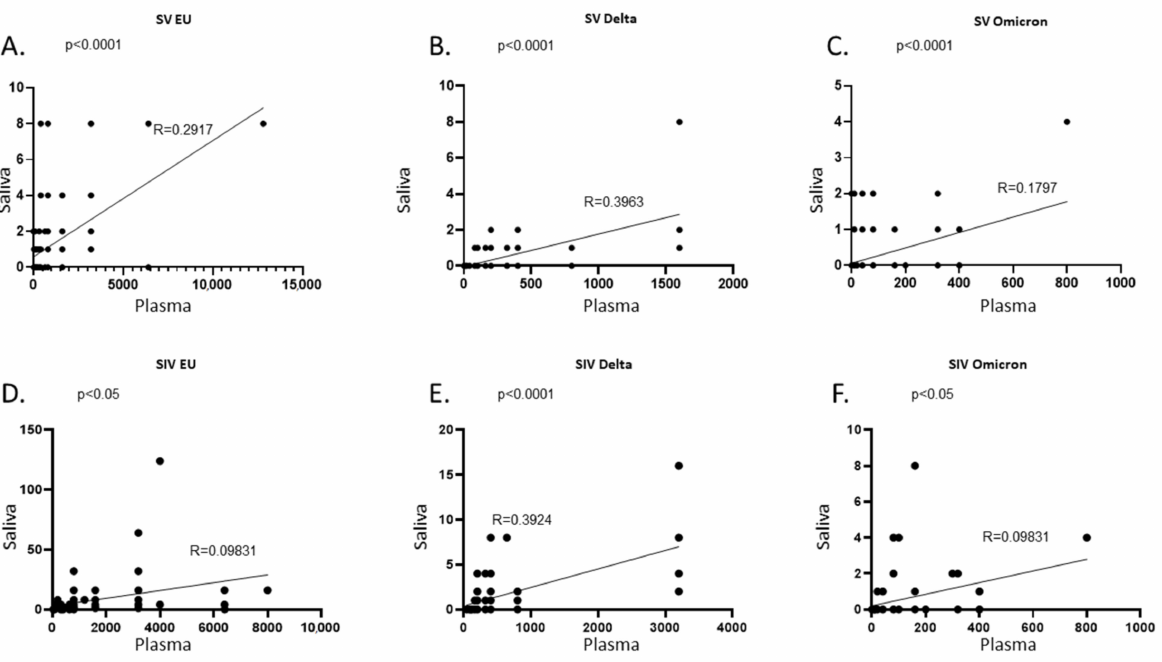
Figure 9. Correlation between NA in plasma and saliva samples. In SARS-CoV-2 Vaccinated subjects (SV) plasma and saliva NA against the EU ( A ), Delta ( B ), and Omicron ( C ) variants were positively correlated. Likewise, in SARS-CoV-2 Vaccinated and infected subjects (SIV) a positive correlation was found between plasma and saliva NA against the EU ( D ), Delta ( E ), and Omicron ( F ) variants. NA at all time points were considered in each